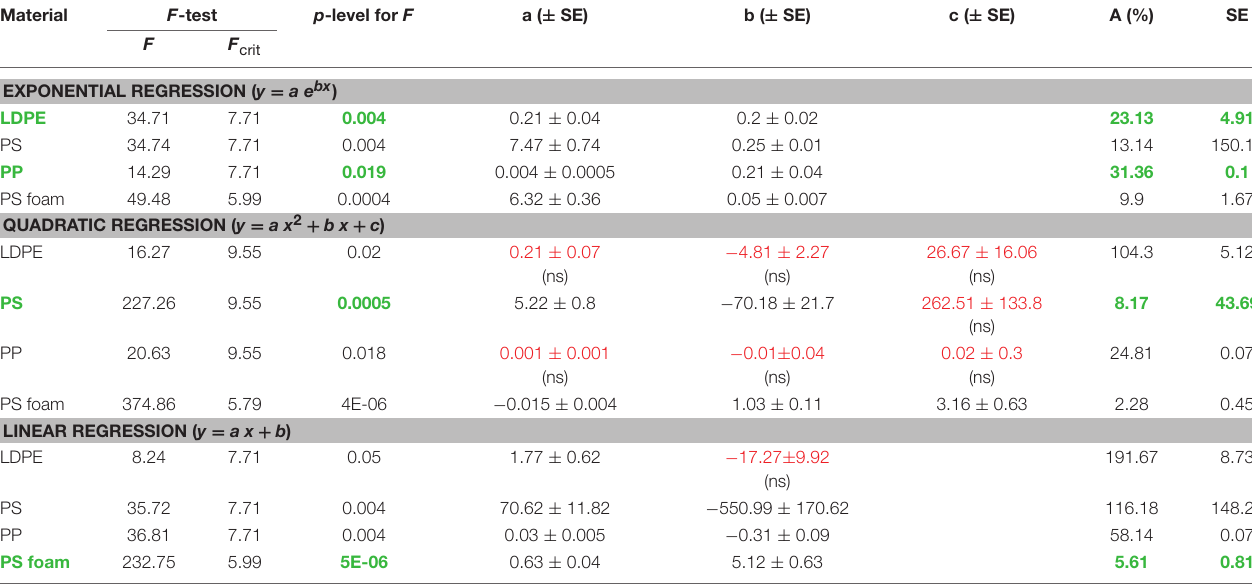
TABLE 2 | Results of statistical analysis of exponential, quadratic, and linear models for relationship between the number of MPs particles and time of degradation of large plastic items in laboratory mixer.